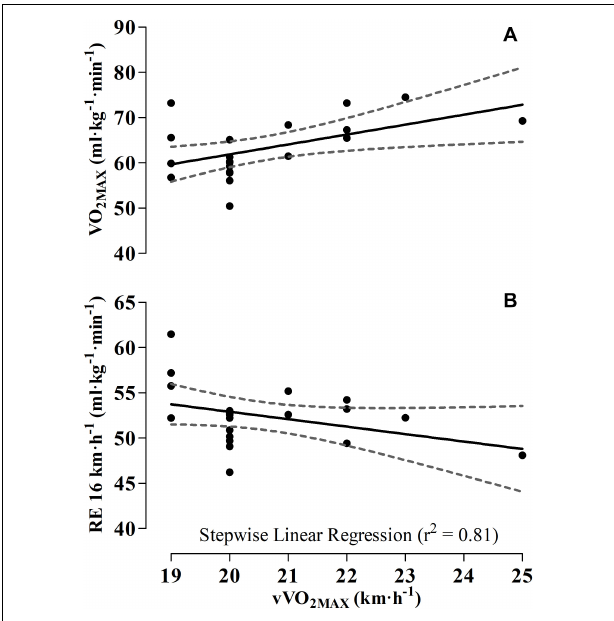
FIGURE 2 | Predicted improvement maximal incremental of running performance (vVO 2 MAX ) with VO 2 MAX (A) and RE (B)